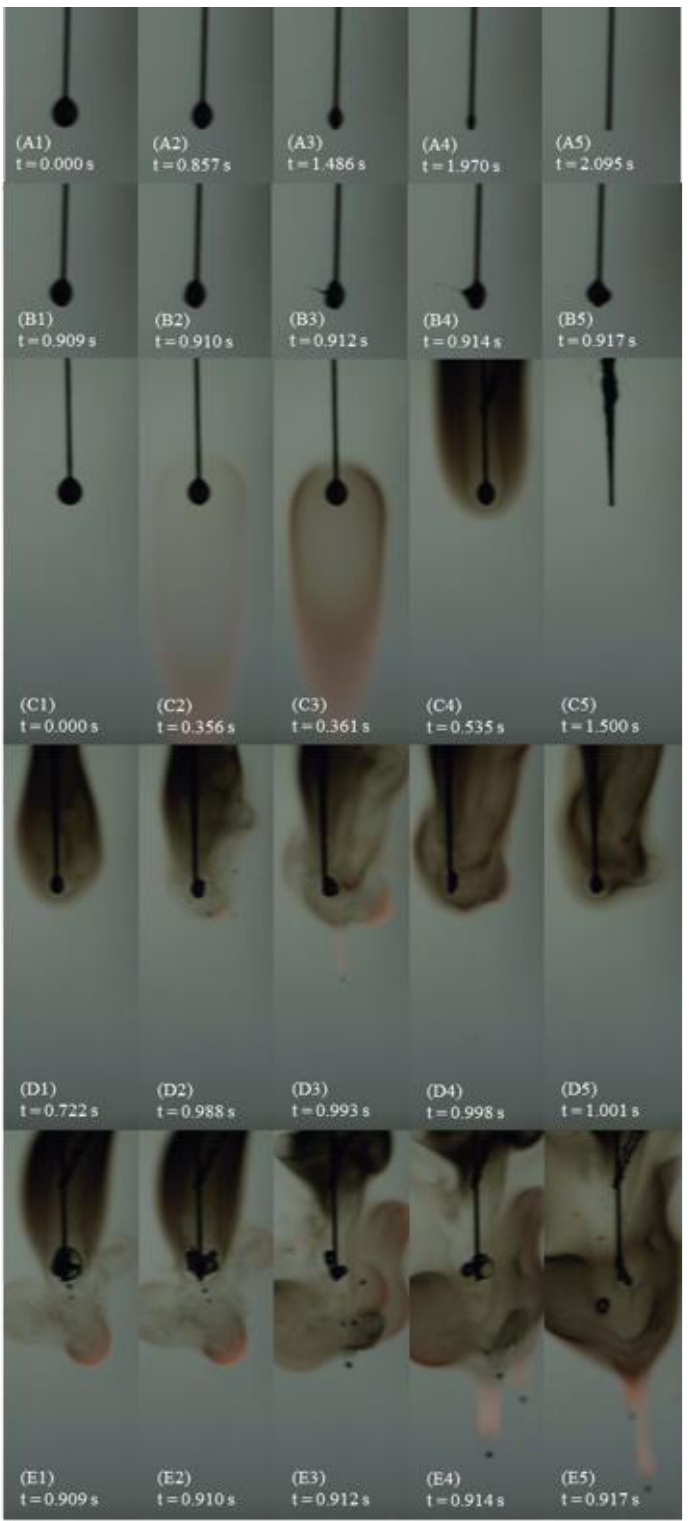
Figure 5. Evaporation, autoignition, puffing, and micro-explosion of JP-10 droplets blended with different concentrations of HPE: ( A1 – A5 ) JP-10, 850 K; ( B1 – B5 ) 0.5% HPE-blended JP-10, 850 K; ( C1 – C5 ) JP-10, 900 K; ( D1 – D5 ) 0.1% HPE-blended JP-10, 900 K; ( E1 – E5 ) 0.5% HPE-blended JP-10, 900 K.